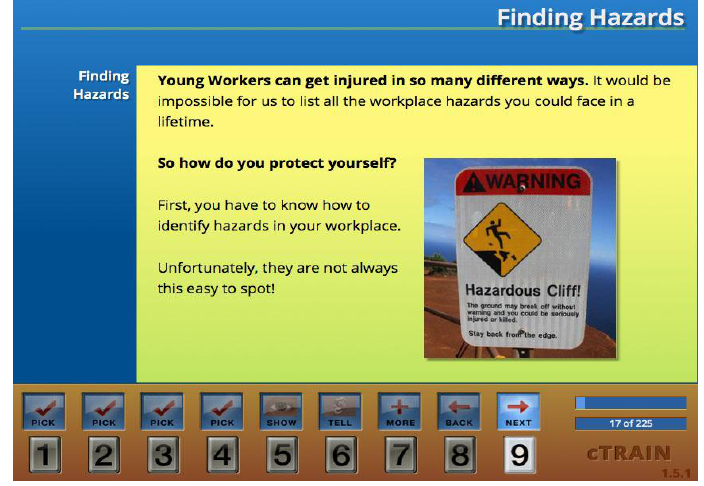
Figure 2. Example of the PUSH screen.